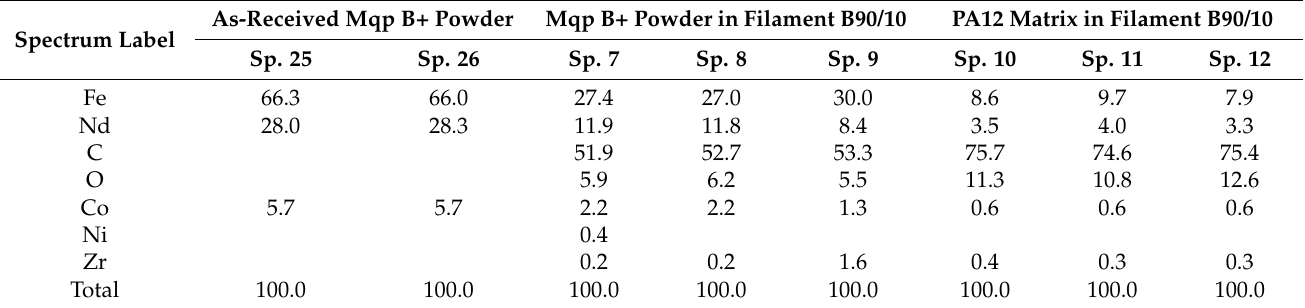
Table 6 . Elemental composition (wt.%) of the as-received Mqp B+ powder and filament B90/10.